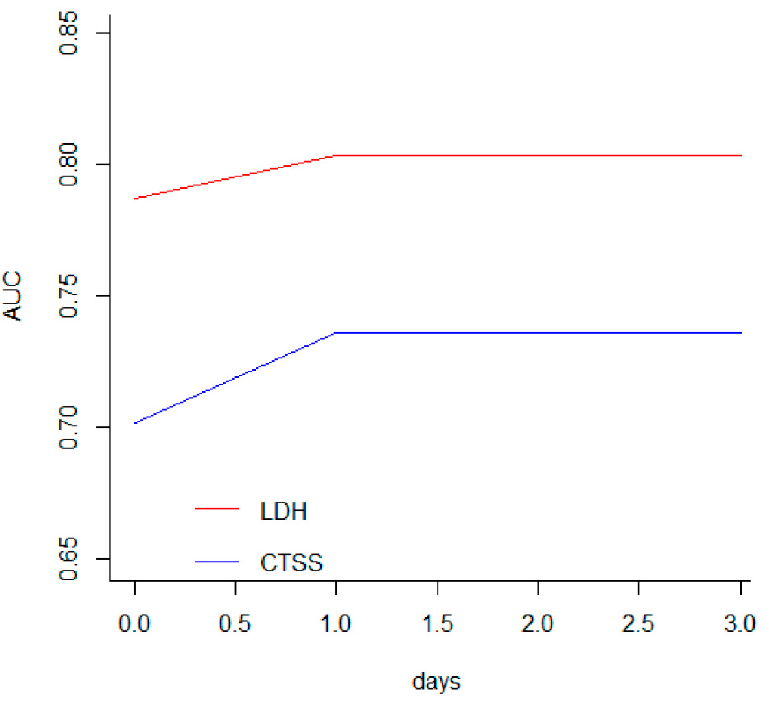
Figure 2. Analysis of the predictive accuracy of LDH and CTSS through the first 3 days from hospital admittance, computed by the time-dependent ROC analysis for censored survival data.